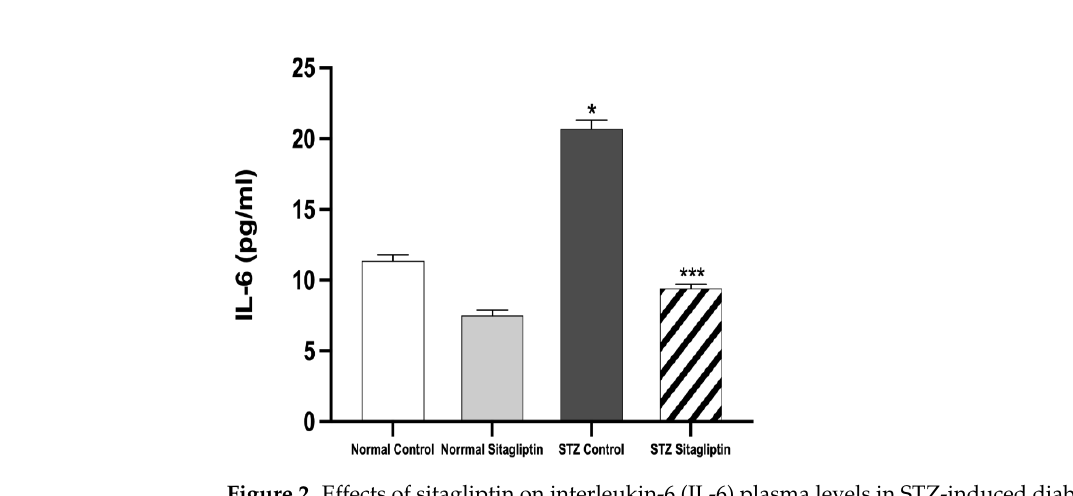
Figure 2. Effects of sitagliptin on interleukin-6 (IL-6) plasma levels in STZ-induced diabetic rats. Data are expressed as means ± SEM, according to a one-way ANOVA followed by the Bonferroni test ( n = 6 animals per group). * p < 0.05 vs. normal control (non-diabetic control); *** p < 0.001 vs. STZ control group; STZ, streptozotocin.